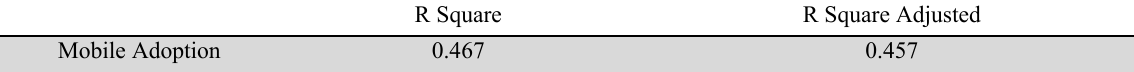
R Square Value R Square R Square Adjusted Mobile Adoption 0.467 0.457